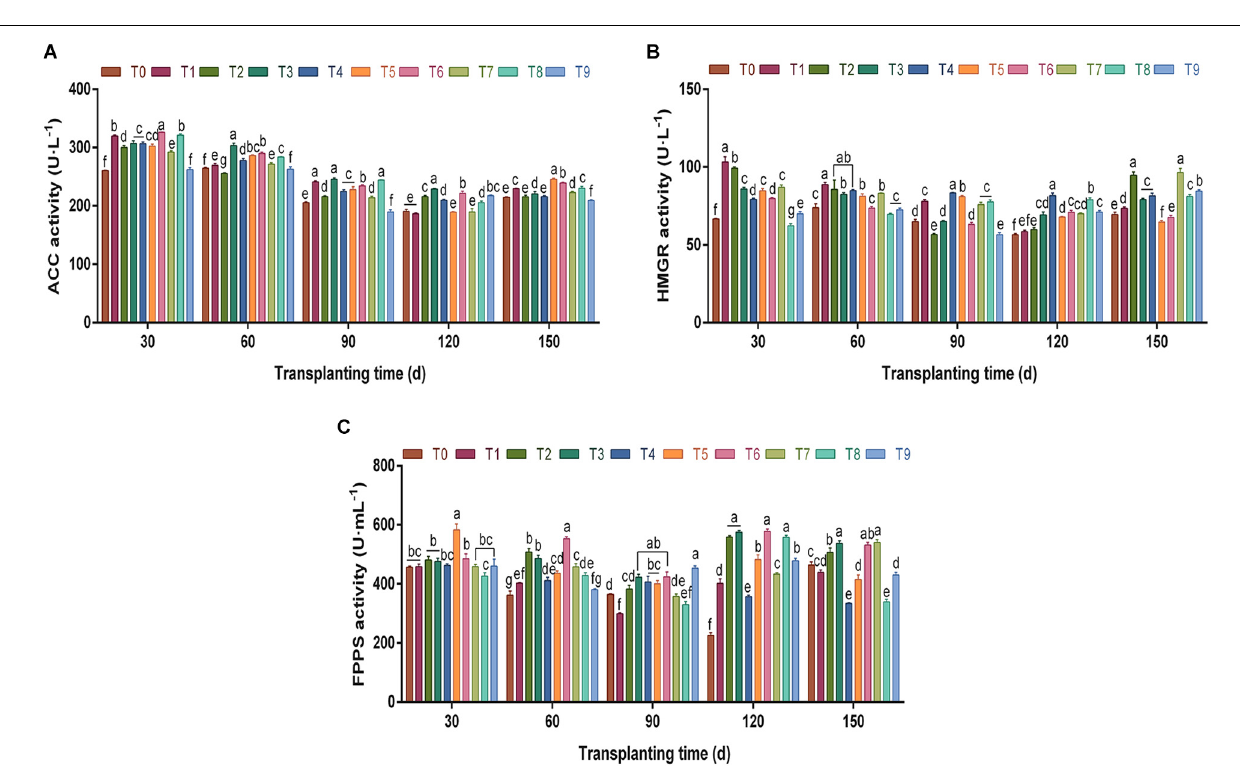
FIGURE 5 | The effects of different NPK combinations on the activities of key enzymes acetyl-CoA carboxylase (ACC) (A) , 3-hydroxy-3-methylglutaryl-CoA reductase (HMGR) (B) , and farnesyl pyrophosphate synthase (FPPS) (C) in the rhizomes of A. chinensis ( n = 3). (a) Initial key enzyme activities of A. chinensis seedlings: ACC 207.76 ± 1.85 U · L − 1 ; HMGR 63.38 ± 1.19 U · L − 1 ; and FPPS 326.67 ± 8.90 U · ml − 1 . (b) Different lowercase letters indicate that the effects of different NPK combinations on A. chinensis were significantly different in the same period ( p < 0.05). (c) The composition of fertilization treatments: T0, N 0 P 0 K 0 ;